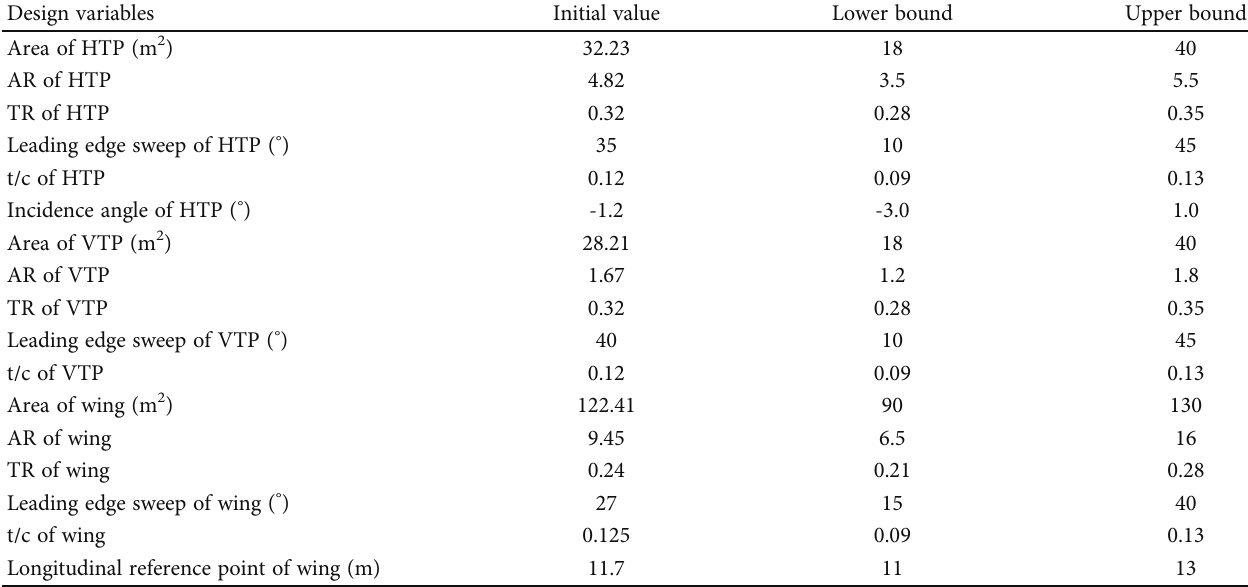
Table 2: A full list of design